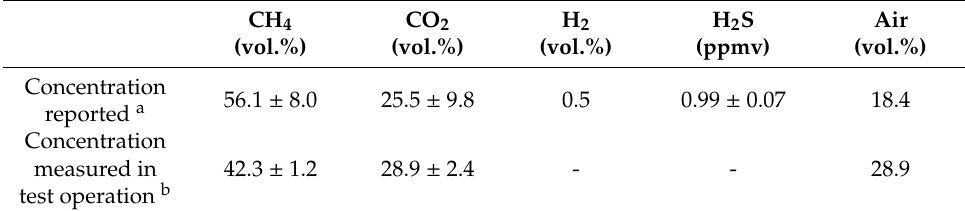
Table 1. Concentration of de-sulfurized biogas from Bali Sewage Treatment Plant (test operation). CH 4 CO 2 H 2 H 2 S Air (vol.%) (vol.%) (vol.%) (ppmv) (vol.%) Concentration 56.1 ± 8.0 25.5 ± 9.8 0.5 0.99 ± 0.07 18.4 reported a Concentration measured in 42.3 ± 1.2 test operation b